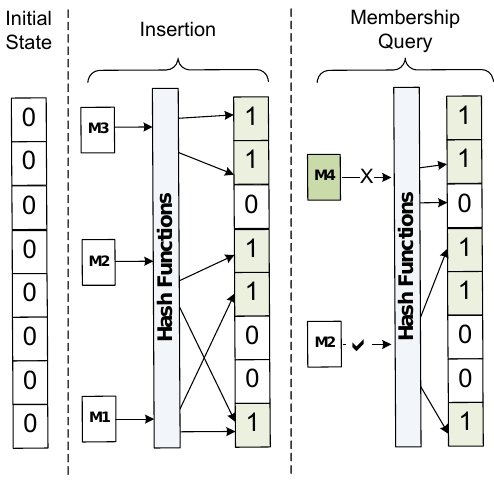
Figure 2. Basic operation of Bloom